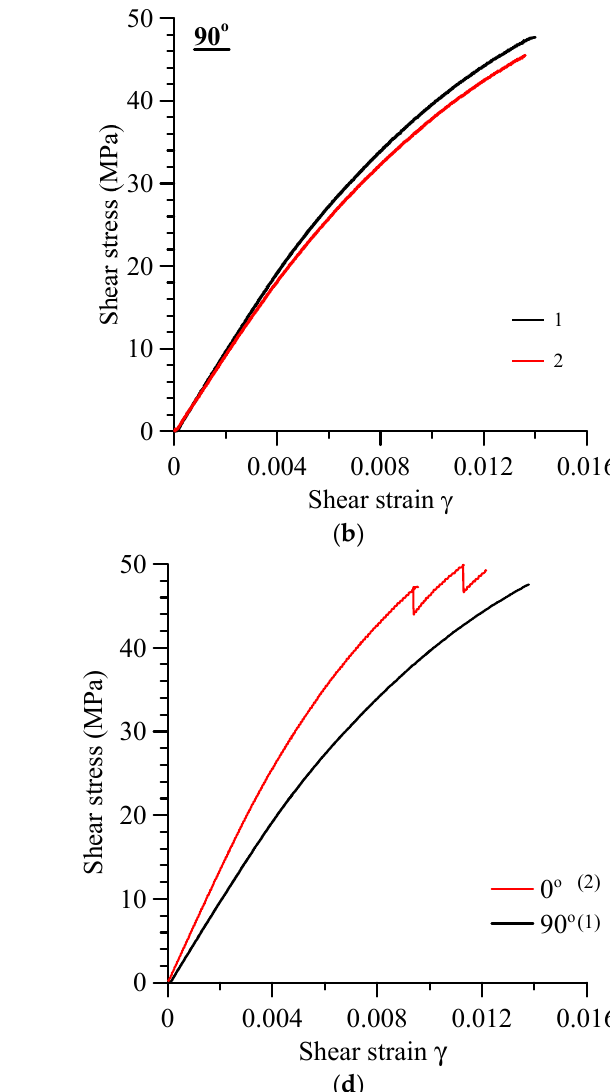
Figure 8. Shear stress–strain curves for different orientations; ( a ) 0° entire curves up to fracture (3 coupons); ( b ) 90° entire curves up to fracture (two coupons); ( c ) 0° expanded zone where load relaxations were noticed; ( d ) comparison curves of 0° and 90° coupons (chose representative). Table 3. Mechanical properties for the shear coupons for the two orientations.